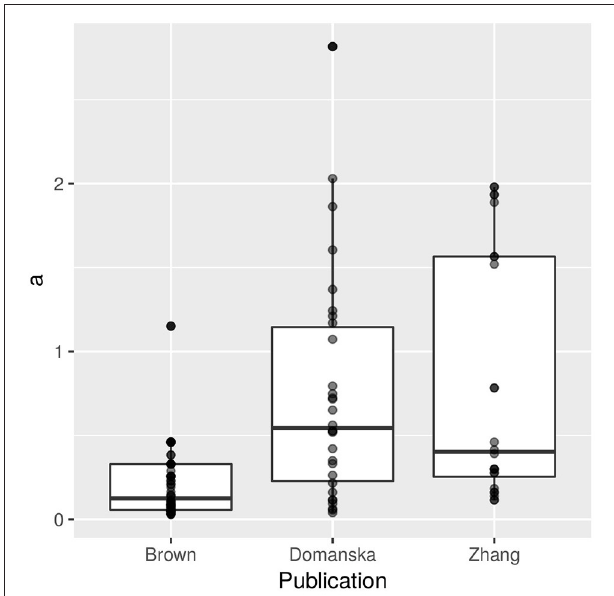
FIGURE 1 | Decay rates a ( N = 120) extracted from three publications (66 from Brown et al., 2014, 30 from Domanska-Blicharz et al., 2010, and 24 from Zhang et al., 2014). Data points have been made transparent to allow visualization of overlap.